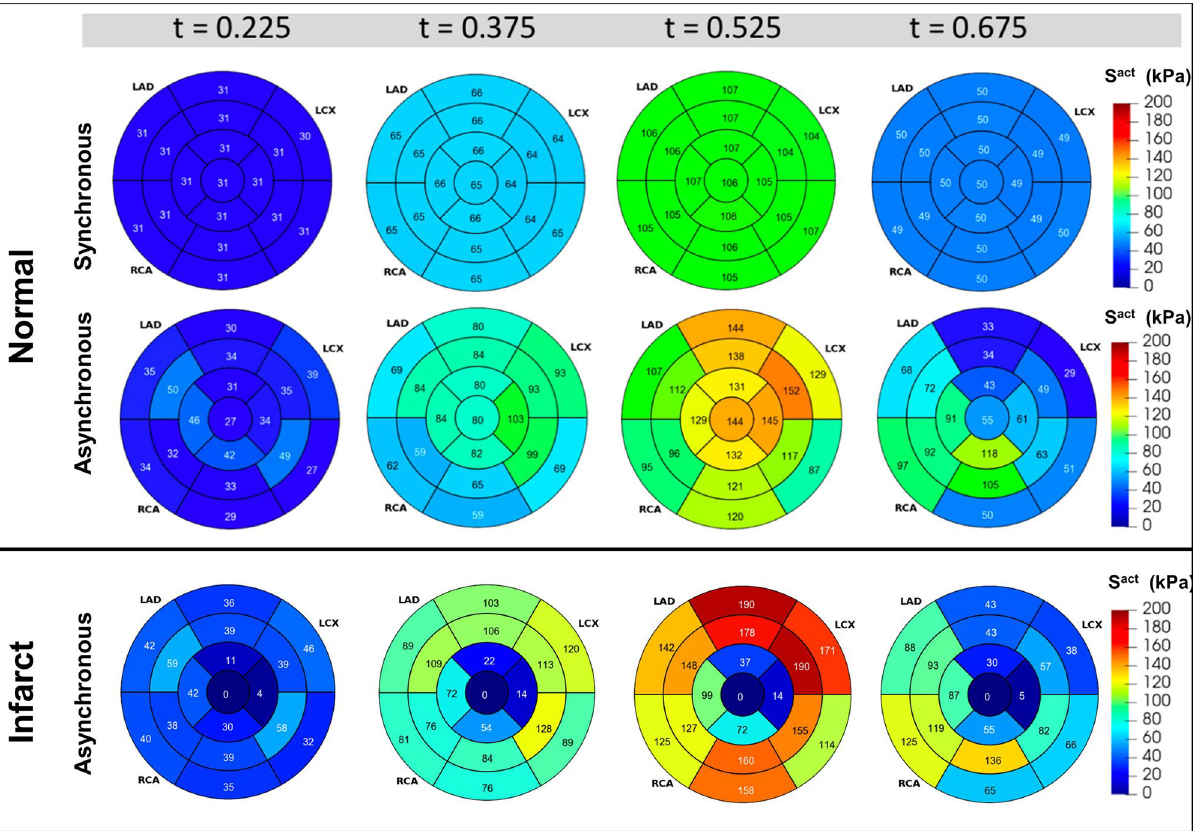
Figure 6. Effect of myocardial infarction and synchronous vs asynchronous on active stress distribution over the course of one cardiac cycle. Endocardial data are shown using a standard AHA segmentation of the LV. All times t are normalized to cycle duration.